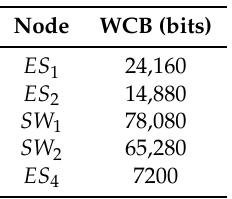
Table 3. Worst-case backlog of processing node.